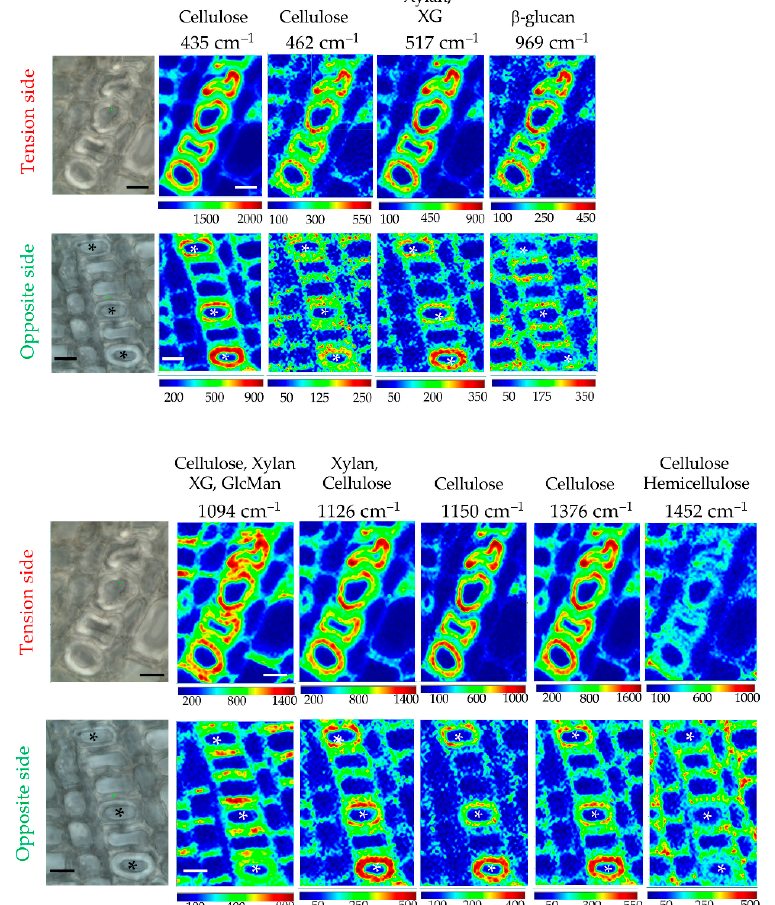
Figure 5. Raman chemical imaging of significant peaks. Cambial zone is located at the bottom of each image. Fiber ‐ tracheids exhibiting a G ‐ layer are symbolized with an asterisk. Intensities were twice as high in G ‐ layer from the tension side than the opposite one. Compared to the opposite side, in the tension side the neighbor cells (fiber ‐ tracheid, ray cells, large vessel) exhibit less intensity in their cell walls (particularly the periclinal wall). Bar = 10 μ m. Normalization was done on the cellulose peak 380 cm –1 . Peak assignments are given in Table S1.